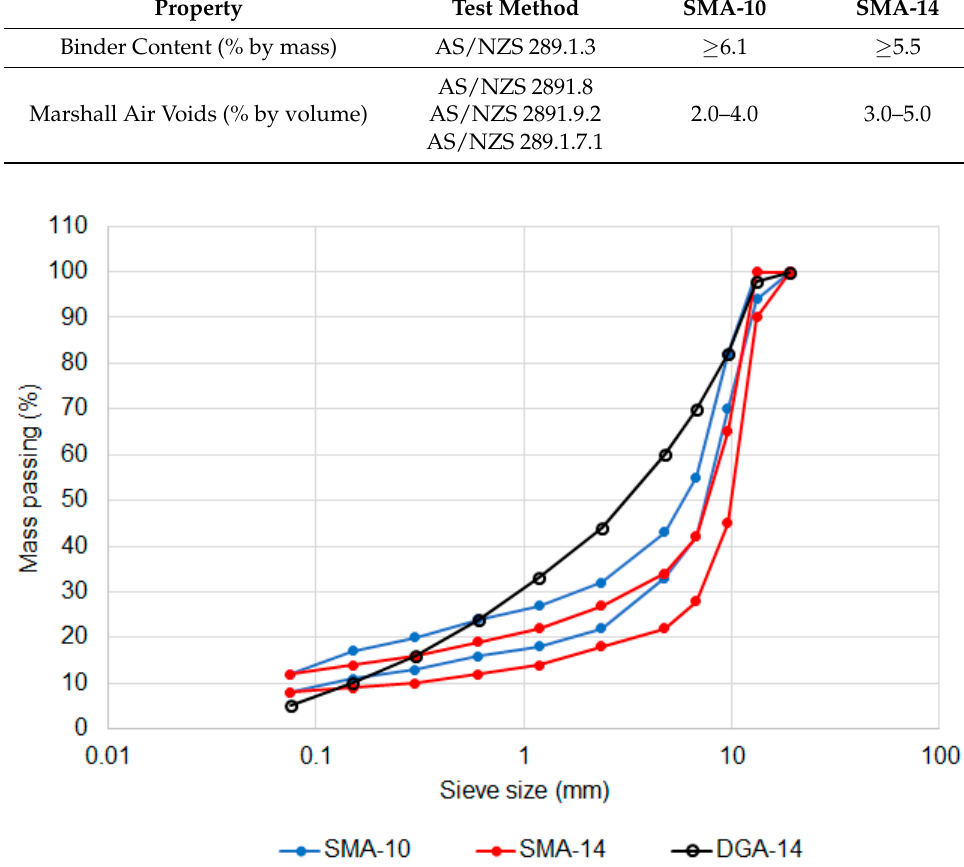
Table 4. SMA additional performance requirements [14].